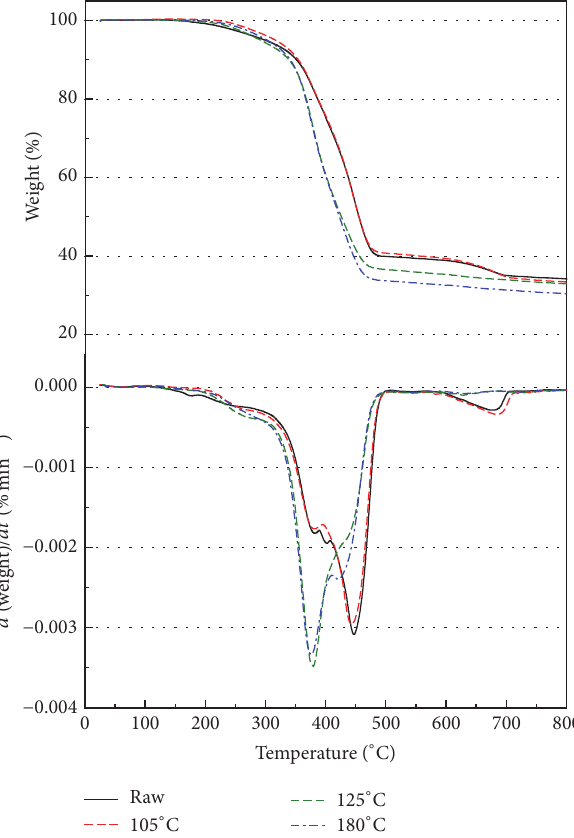
Figure 7: TGA and DTG curve of thermal aged polyketone/NR